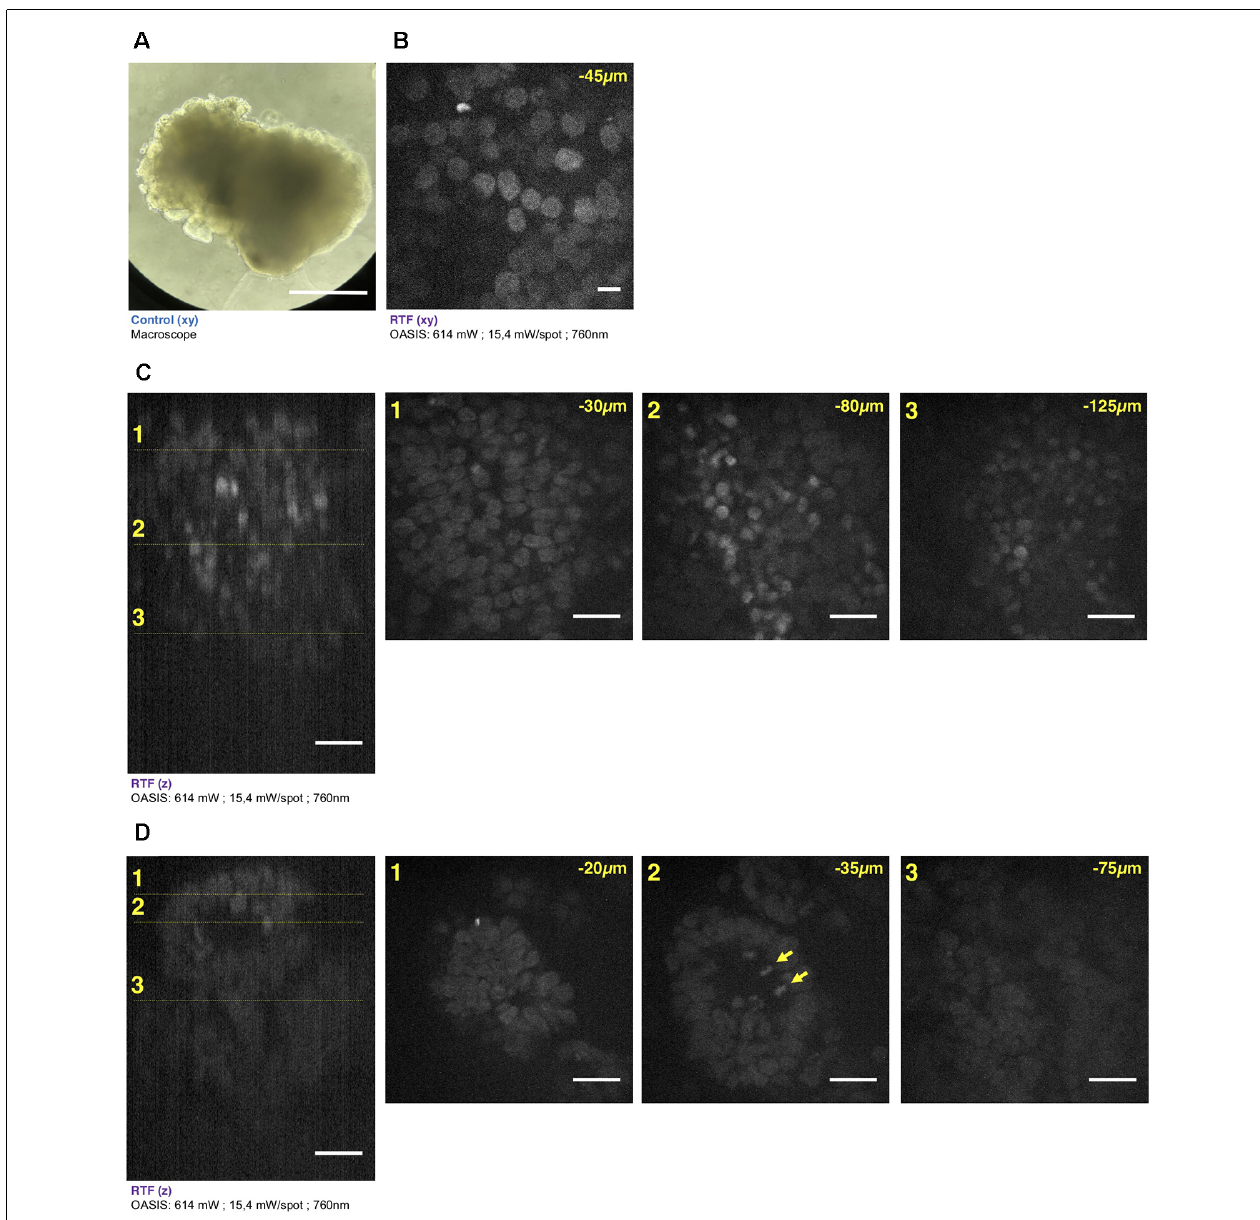
FIGURE 5 | Brain organoid imaging with OASIS. (A) Macrophotography of a day 11 brain organoid before clearing and observation on the OASIS microscope; scale-bar: 300 µ m. (B) Image acquired in the center of the organoid at 45 µ m below the surface; stain: TO-PRO3; scale-bar: 10 µ m. (C) z-reconstruction (left) and xy-acquisition (right) at respectively 30 µ m (1), 80 µ m (2) and 125 µ m (3) below the surface of the organoid; stain: TO-PRO3; scale-bar: 25 µ m. Note the change of the morphology of the nuclei in the center of the region of interest when depth increase. (D) z-reconstruction (left) and xy-acquisition (right) at respectively 20 µ m (1), 35 µ m (2) and 75 µ m (3) below the surface of the organoid; stain: TO-PRO3; scale-bar: 25 µ m. Note the globular structure (neuro-epithelium) that can also be observed on the macroscopy and numerous mitosis inside this structure (arrows). Except in (A) , all images were acquired after the clearing of the organoid with the RTF protocol. Note the image quality across the entire imaged